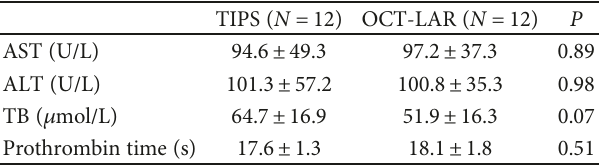
Table 4: Live functions at baseline.